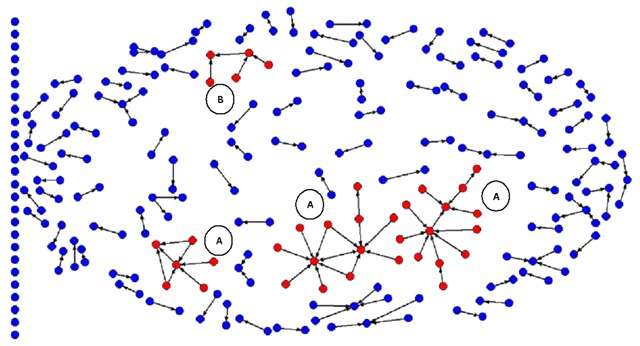
Network of first and corresponding authors in 409 articles on children environmental health in Latin America.Arrows start from the first to the corresponding author. Letters indicae models of collaboration: A) Centralized, B) Distributed.